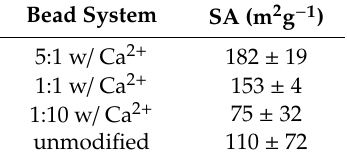
Table 1. Dye-based Surface Area (SA) using the anion form of PNP at pH 8.4 ±